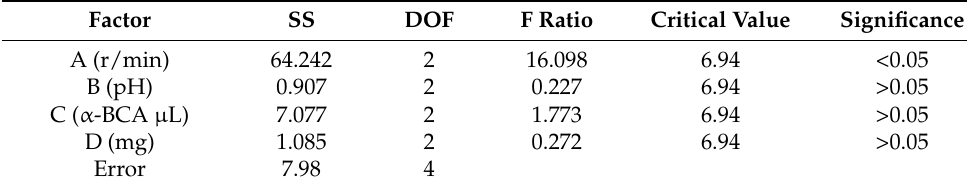
Table 4. Analysis of variance of orthogonal experimental